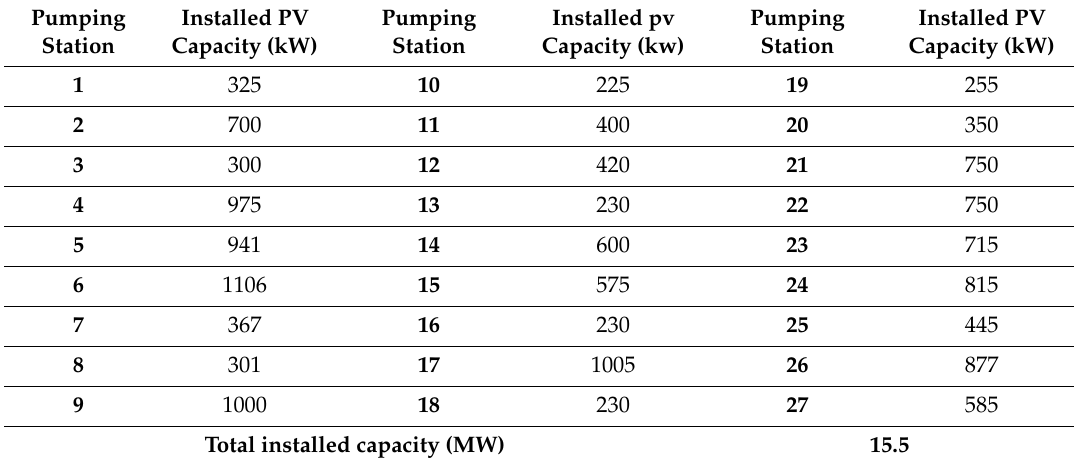
Table A3. Installed power of the self-consumption photovoltaic